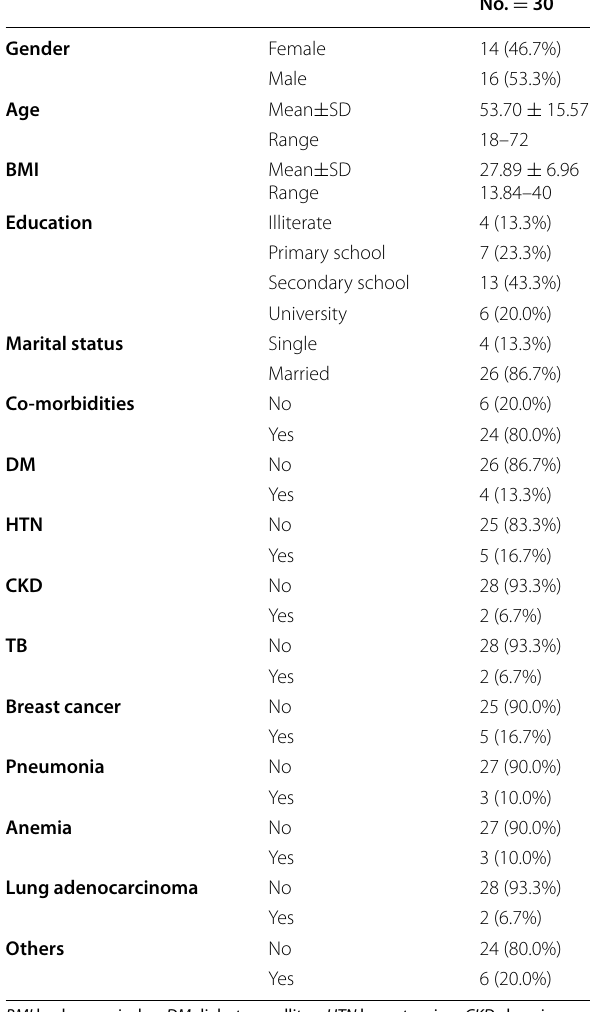
comorbidities, and associated conditions of the studied patients